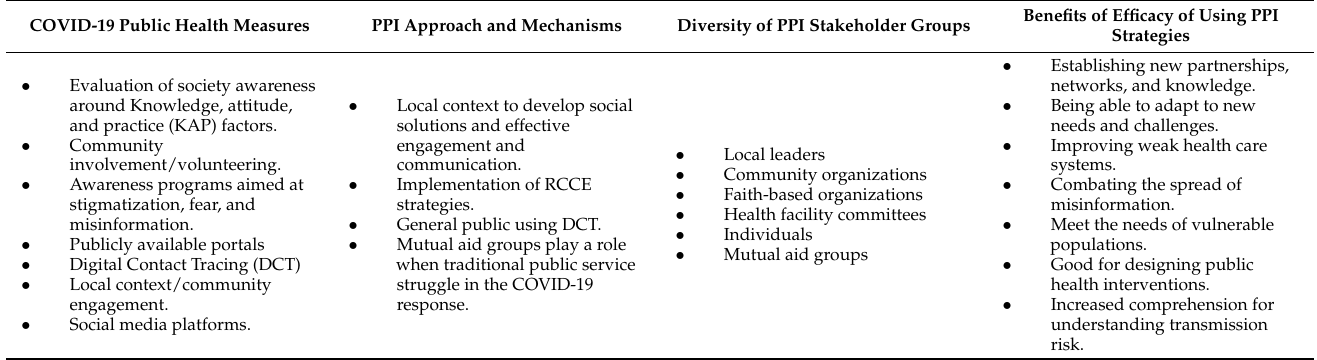
Table 5. Overview of evidence for patient and public involvement (PPI) included in the